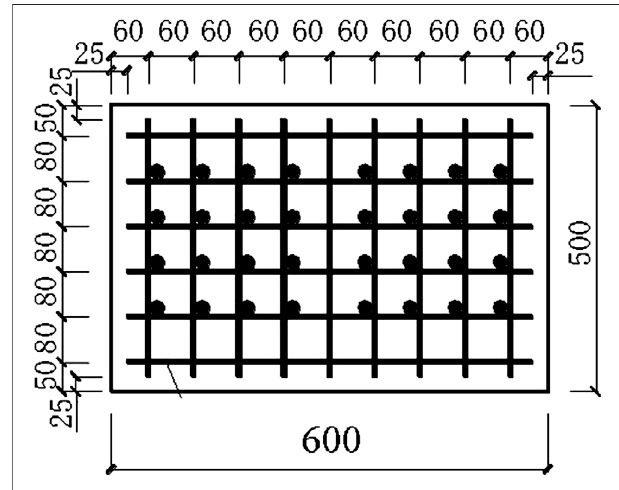
FIGURE 2 | Dimension of the column section of specimens JD-1, JD-2, and JD-3.